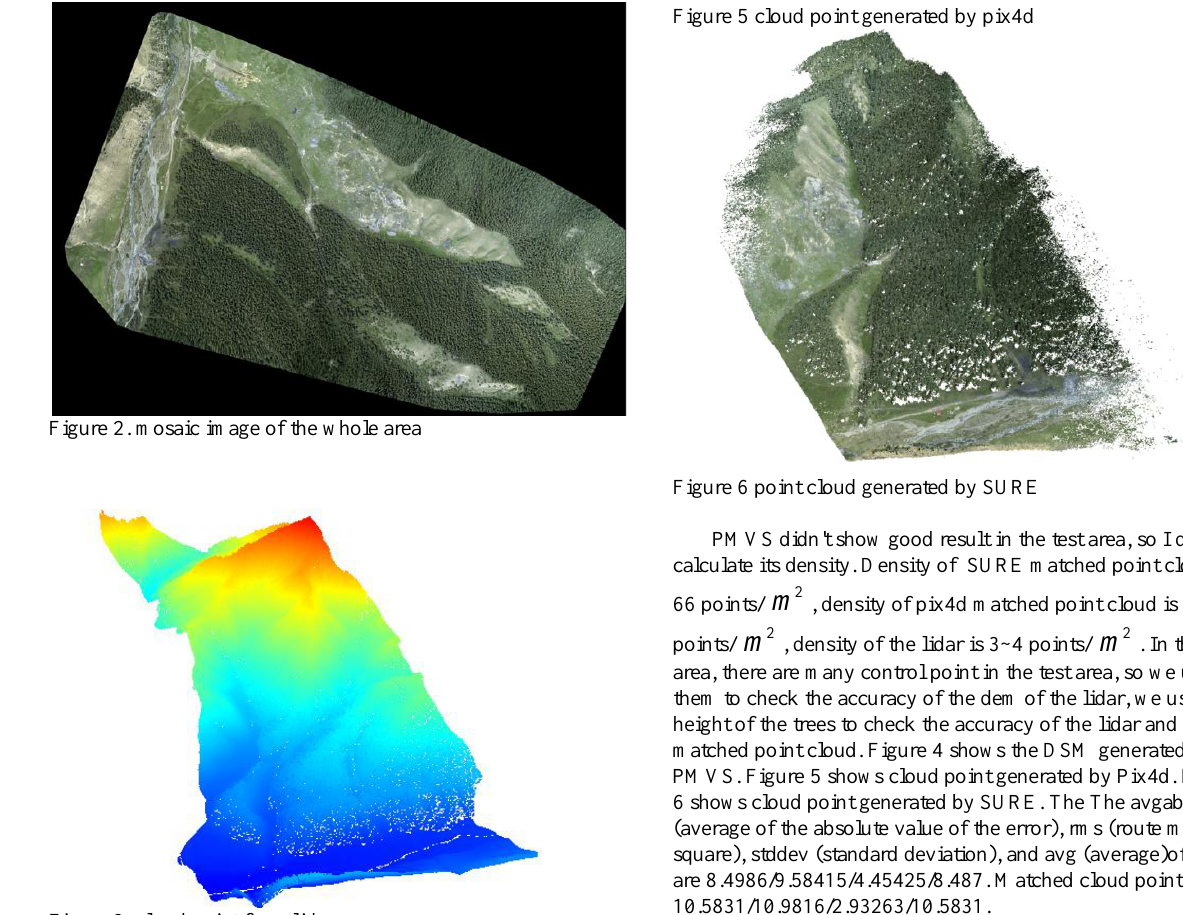
Figure 5 cloud point generated by pix4d